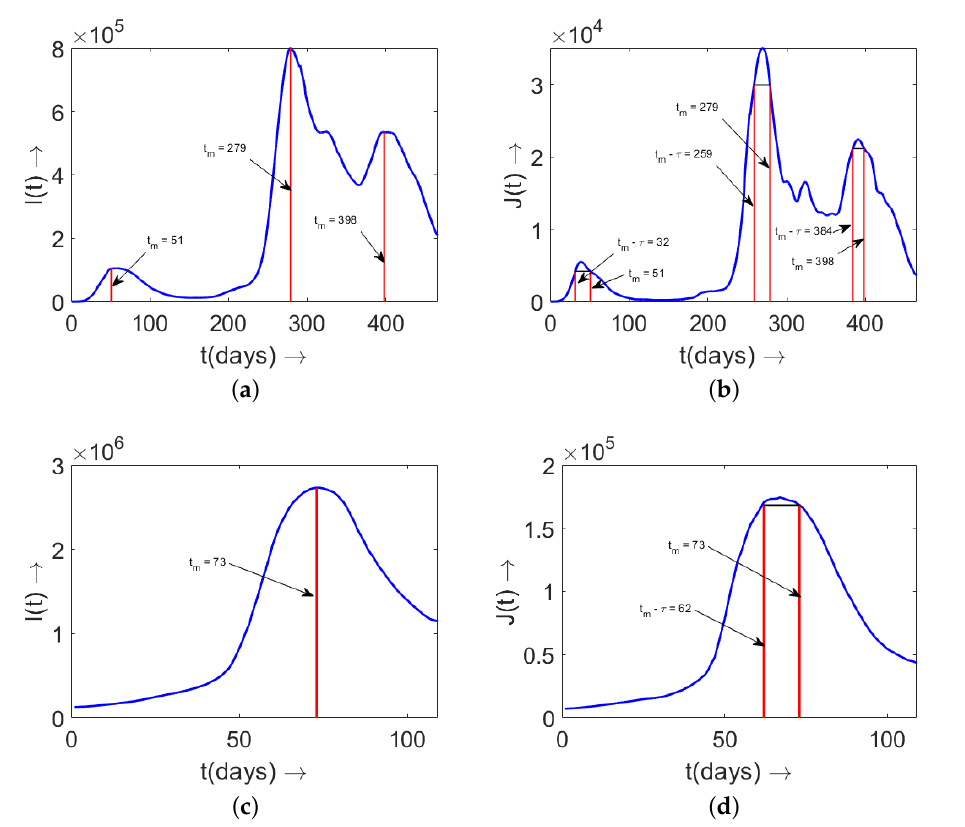
Figure 6. Estimation of the disease duration τ using the data around different peaks of COVID-19 in Italy. ( a , b ) Time t = 0 corresponds to 21 February 2020. The obtained value of τ is 19 days for the first peak, 20 days for the second peak, and 14 days for the last peak. ( c , d ) Time t = 0 corresponds to 10 November 2021 (which corresponds to the Omicron outbreak), and the obtained value of τ corresponding to the Omicron outbreak is 11